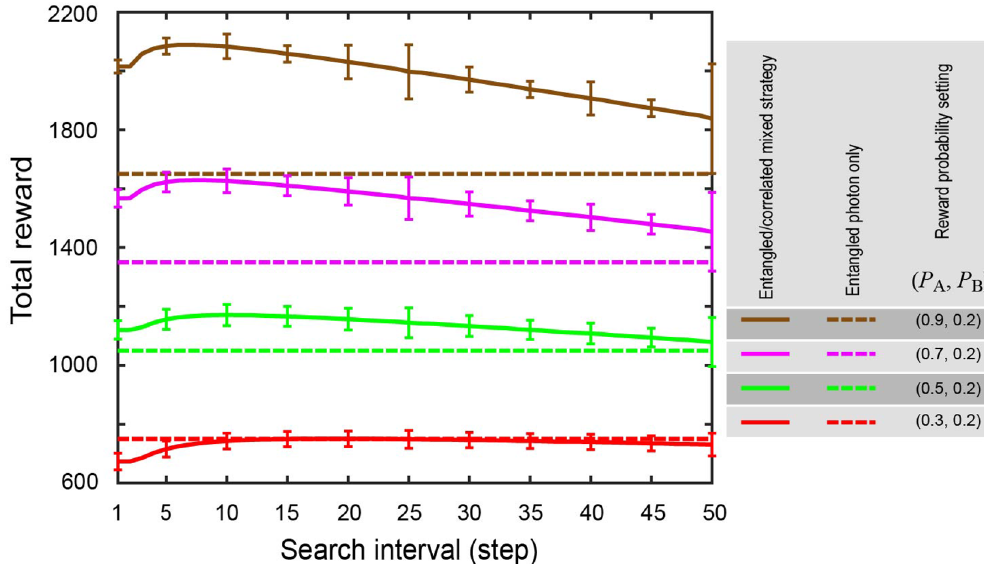
Figure 5. Total rewards by the mixed strategy and the entangled photon only strategy for different general reward environments. The reward environments are given by P A = 0.3, 0.5, 0.7, 0.9 and P B = 0.2. The entangled photon only strategy yields different total rewards depending on the summation of P A and P B . The mixed strategy gains greater total rewards than the entangled photon only strategy as P A becomes larger. On the other hand, the gain is negligible or even negative when the difference between the reward probabilities is small ( P A = 0.3, P B =